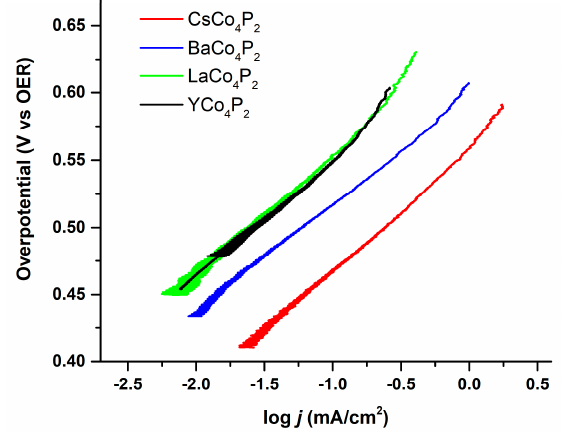
Figure 6. Tafel plot of heterogenized Co 4 POM on glassy carbon electrodes with different counterions. Conditions: 1 mV/s iR compensated chronoamperometry in 0.1 M pH 8 sodium borate buffer and 0.1 M KNO 3 electrolyte solution. Reference electrode, Ag/AgCl (1.0 M KCl); counter electrode, graphite.